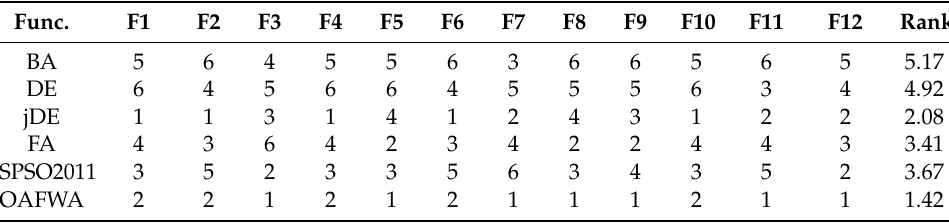
Table 12. Ranks for the six algorithms when popSize = 40.